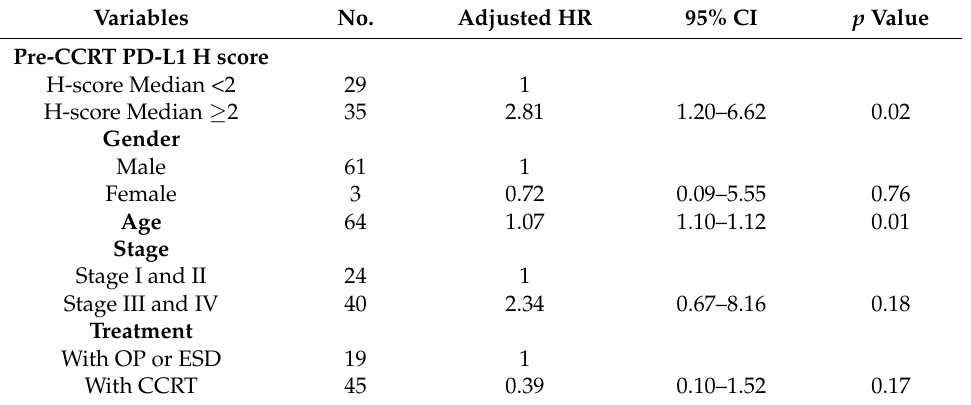
Table 2. Multivariate analysis of factors associated with overall survival of the 64 patients.